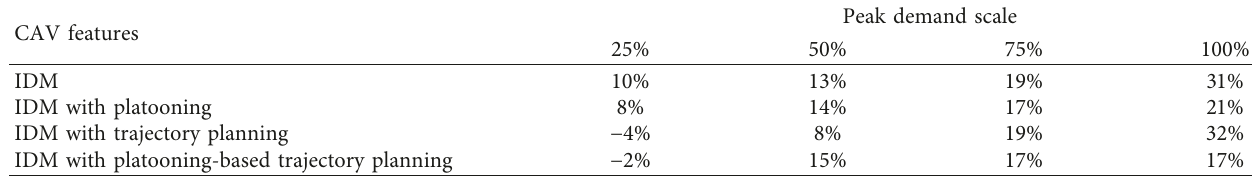
Table 5: Average traffic delay improvement magnitudes of superstreet compared to the equivalent conventional intersection with different CAV Features.